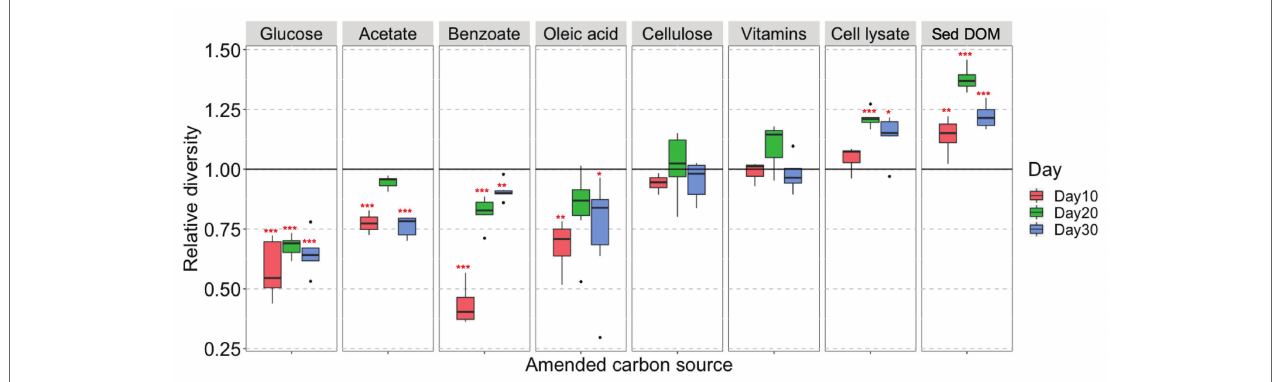
FIGURE 2 | Box and whisker plots illustrating the relative diversity of bacterial community in different C-amended enrichments as compared to the unamended control. Relative diversity is calculated as Hi’ / H0’ . Hi’ is Shannon’s diversity index of individual sample, H0’ is the average Shannon’s diversity index of unamended control at corresponding sampling time point. Significant difference between the C-amended enrichments and the unamended control is indicated by *** when p < 0.001, ** when p < 0.01, and * when p < 0.05.